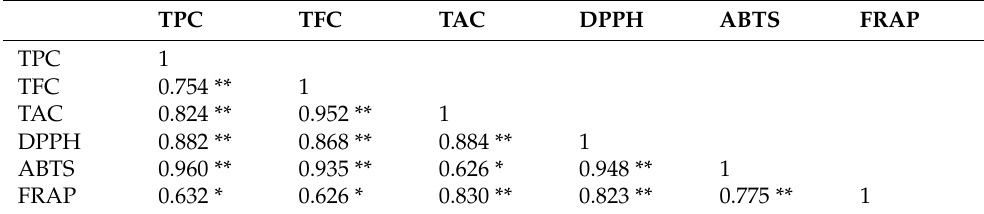
*, p < 0.05; **, p < Table 4. Correlations between total phenolic contents, total flavonoid contents, total anthocyanin contents and antioxidant activities. TPC TFC TAC DPPH ABTS FRAP